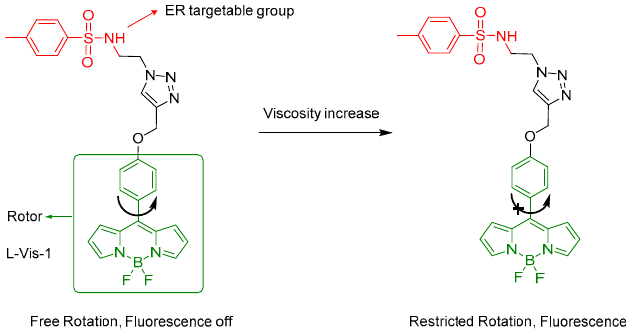
Figure 23. Design of L − Vis − 1 and its fluorescence response mechanism to viscosity [85].